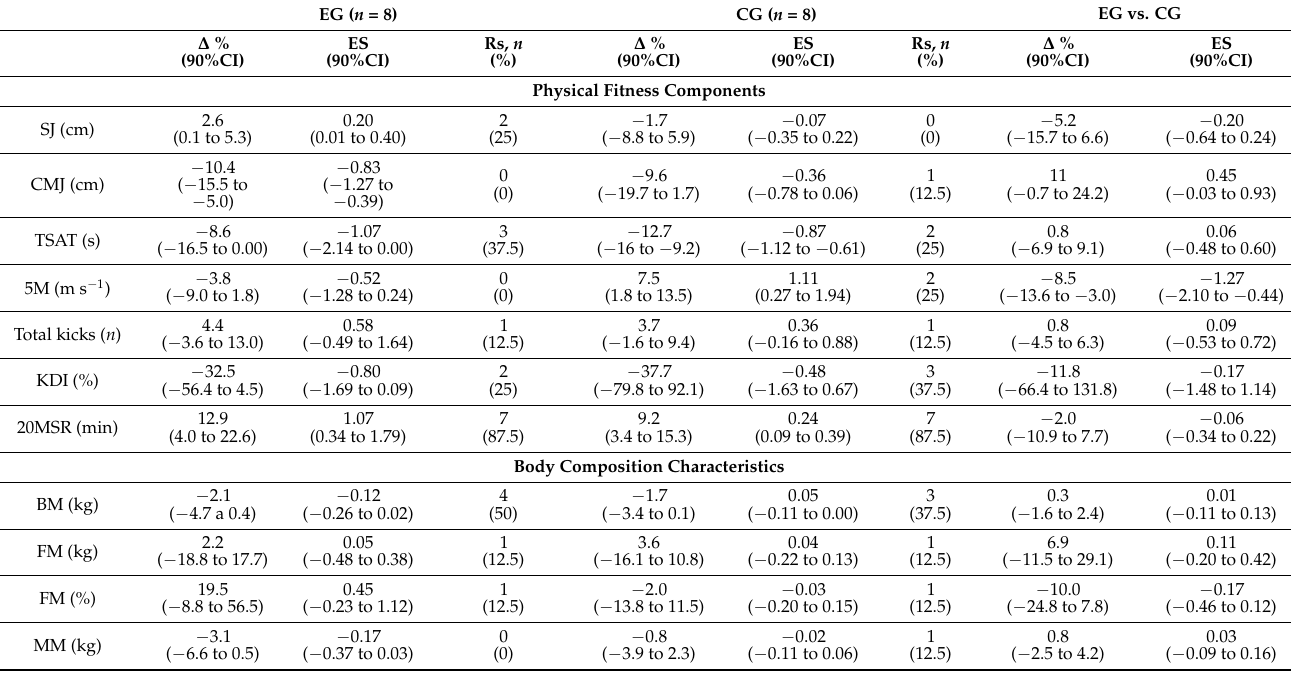
Table 3. Differences and rates of responders and non-responders to HIIT and traditional training